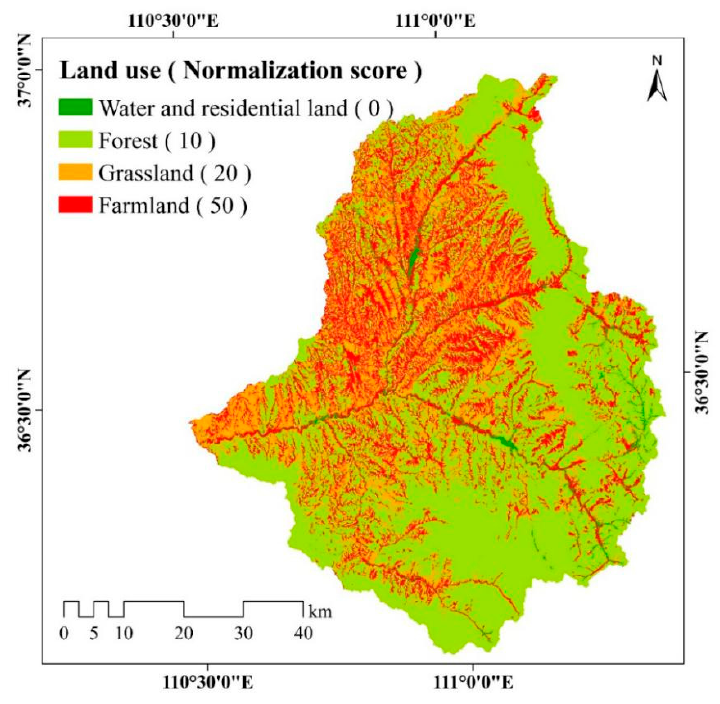
Figure 5. Spatial distribution of Land use in the study area. There are five types of land use including forest, grassland, farmland, water and residential land. Di ff erent color represent di ff erent types. Higher normalization score of land use represent a greater impact on soil